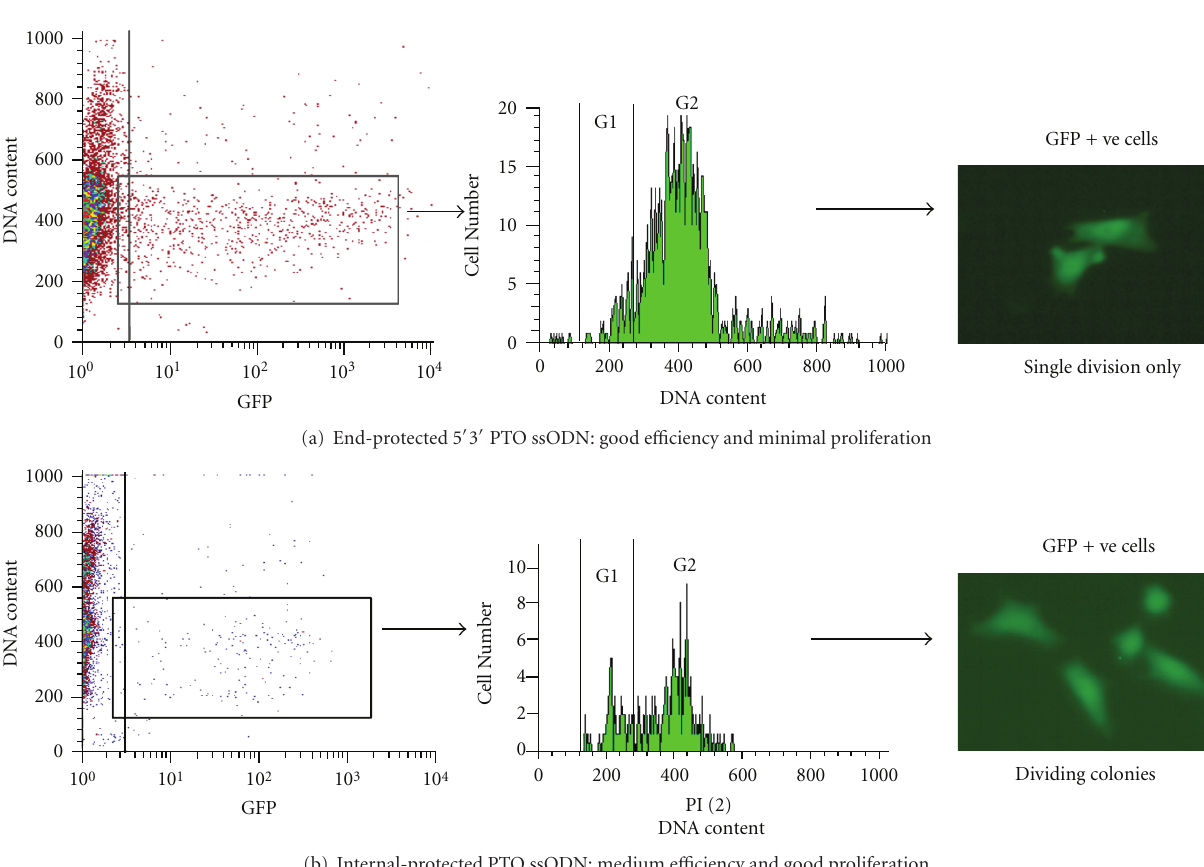
Figure 3: E ff ects of nuclease-protected ssODNs on targeted gene repair. Recombinant cells expressing mutated (nonfluorescent) green fluorescent protein (GFP) were targeted with two ssODNs, one with three phosphorothioate (PTO) residues at each end (a) and the other with four internal PTOs at the central correcting segment (b). Posttargeting, the green cells were counted by flow cytometry (left panels), stained for cell cycle analysis (central panels) and cultured to observe cell growth (right panels). The PTO end-protected ssODN gave a much higher rate of gene correction, as measured by the number of green cells (boxes in left panels). However, this resulted in DNA damage and accrual of cells in the G2 phase, whereas the GFP+ve cells obtained after internally protected ssODN targeting had a markedly greater proportion in G1 (central panel). Significantly, only the occasional divided pair of green cells was noted in cultures treated with end-protected ssODN, whereas actively replicating green cells were evident when the internally protected ssODN was used (right panels).